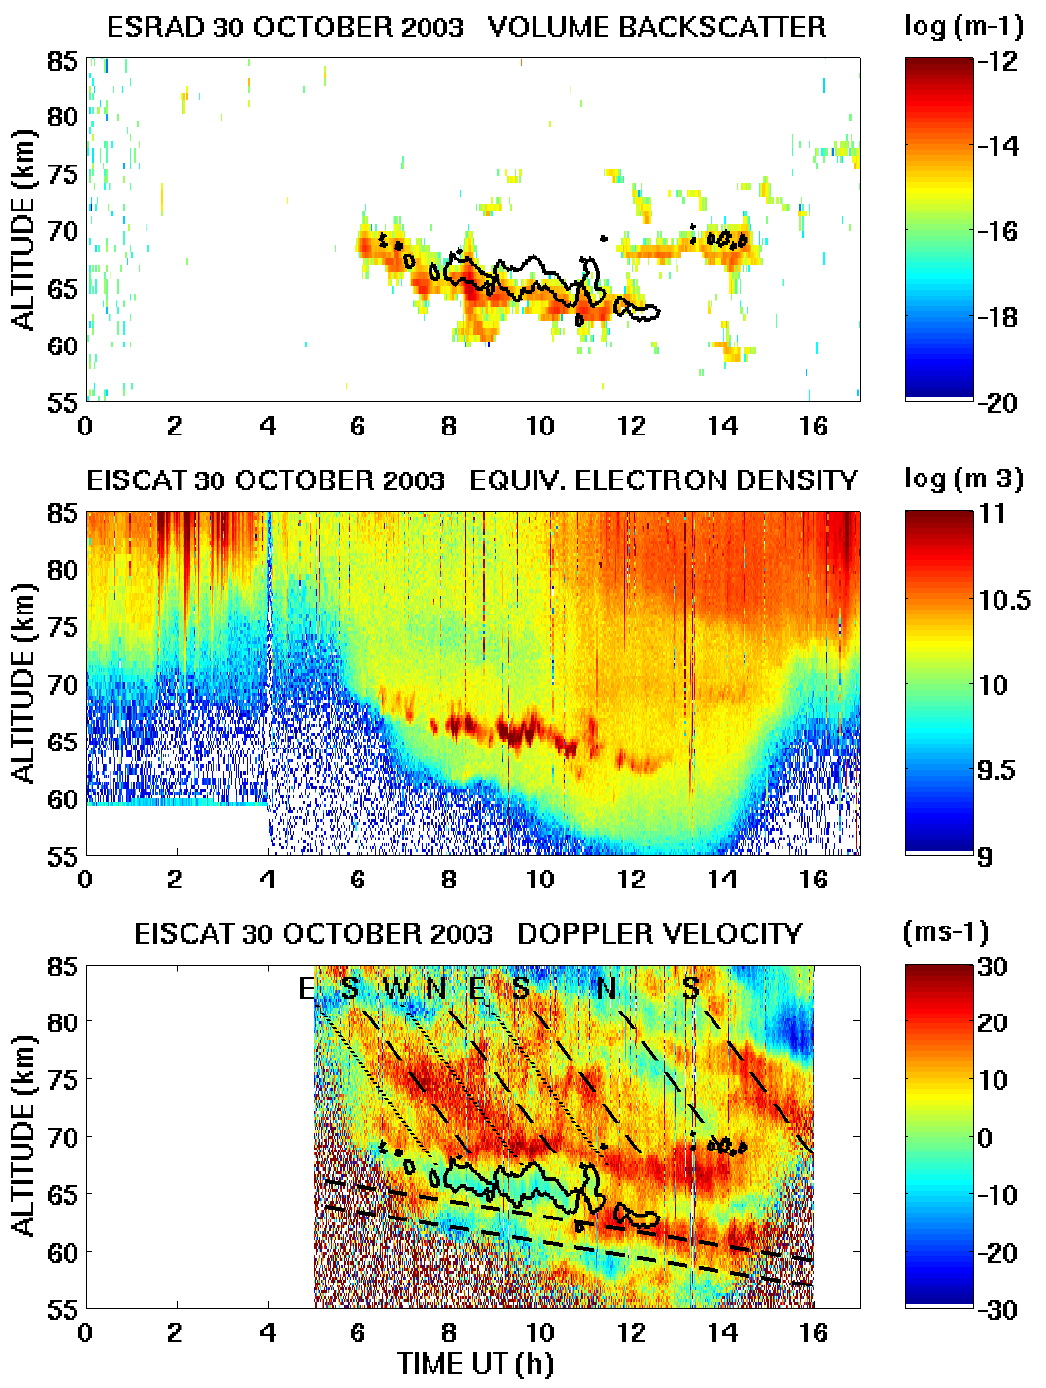
Fig. 1. ESRAD and EISCAT observations for 30 October 2003. Upper panel: volume backscatter from ESRAD; middle panel: equivalent electron density from the EISCAT VHF rada; lowermost panel: Doppler velocity of radar scatterers along the direction of the radar beam (inclined at 60 ◦ elevation towards the north, (positive towards the radar)). Superimposed contour lines on the uppermost and lowermost panels indicate the height/time location of the PMWE seen by EISCAT. In the lowermost panel, the dashed lines at low altitudes indicate the maxima andminima in the wave velocity field used to estimate vertical wavelength and apparent period of the main inertio-gravity wave. The dashed and dotted lines at higher altitudes indicate the inferred positions of maximum winds in a second inertio-gravity wave (see text for further